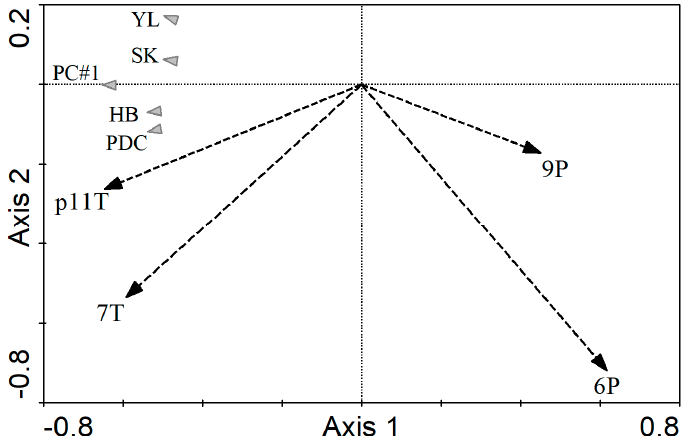
Figure 7. The redundancy analysis between the five chronologies and the climate variables for the common period (1961–2010). Only significant ( p < 0.05) climate variables were presented. The longer vector of the climate factor (dotted line) indicated the greater contribution. The shorter perpendicular line between the chronology (triangle) and the climate vector (itself, or the extension line) indicated a higher correlation between them. Chronology (gray triangle) and climate vectors pointing the same direction represented a positive correlation, and in opposite directions, indicated a negative correlation. SK: Shika Snow Mountain; PDC: Potatso National Park; HB: Haba Snow Mountain; YL: